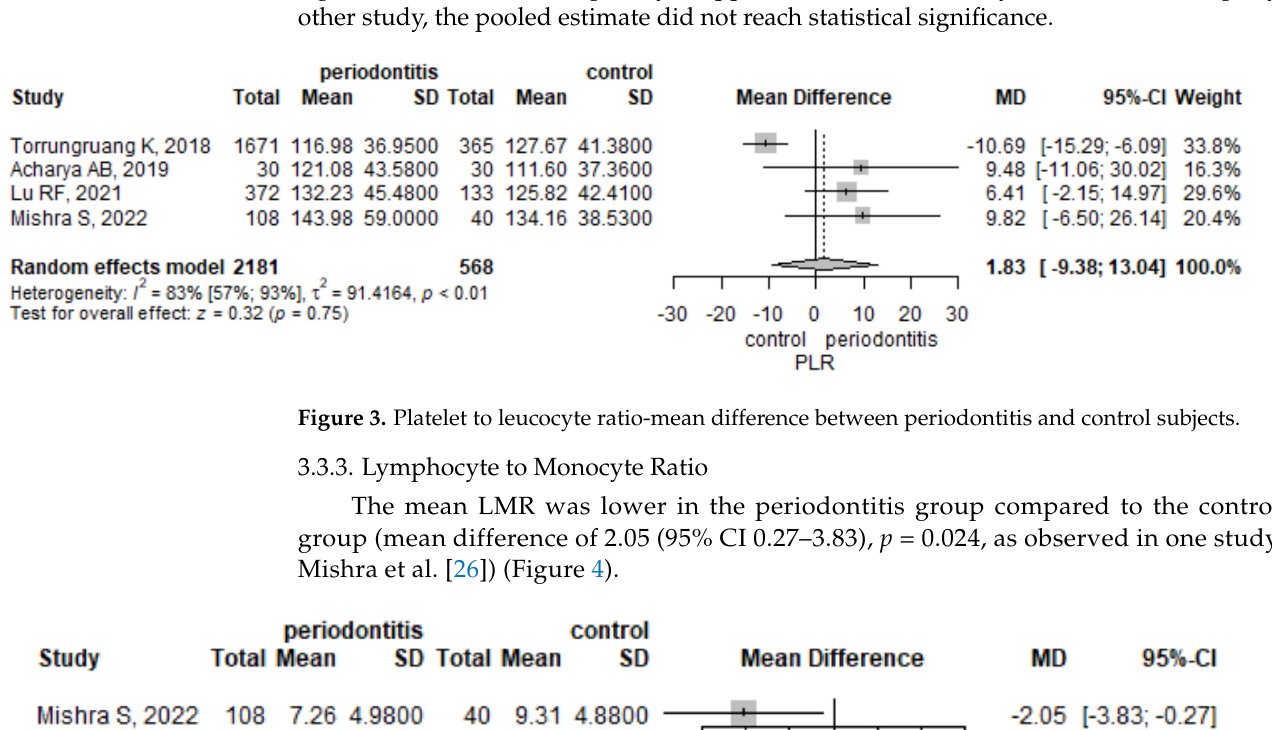
Figure 2. Neutrophile to lymphocyte ratio-mean difference between periodontitis and control sub- jects.